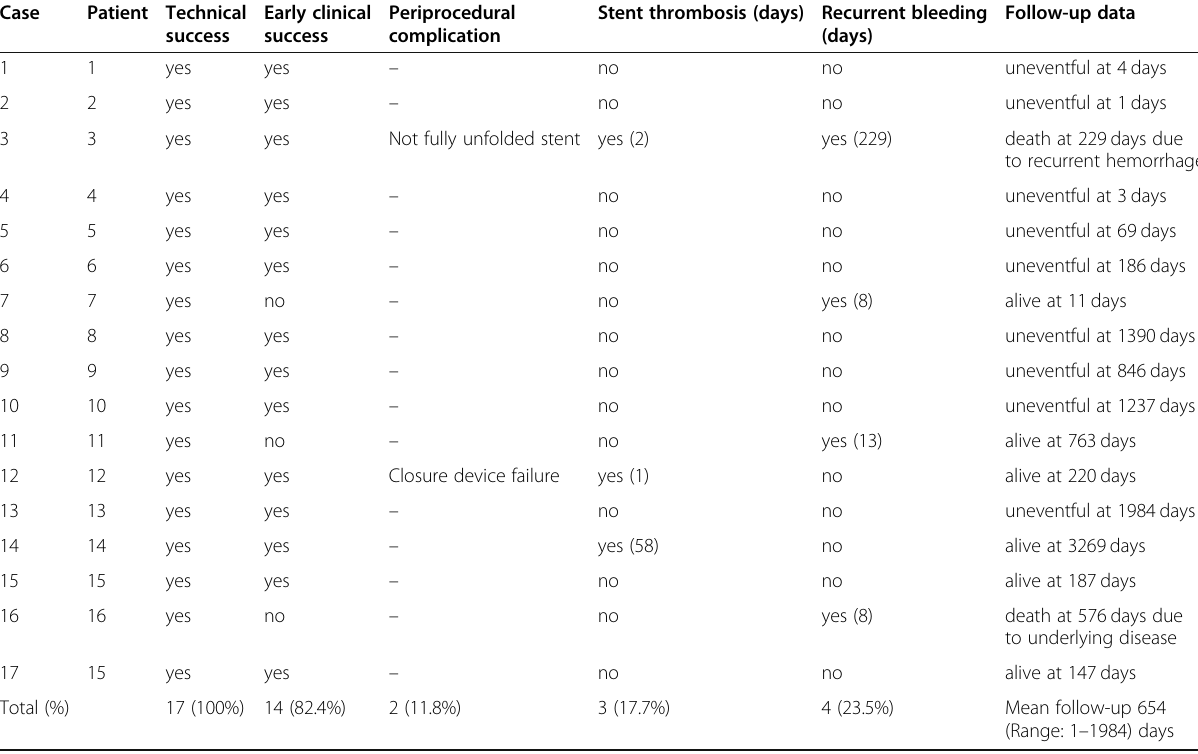
Case Patient Technical